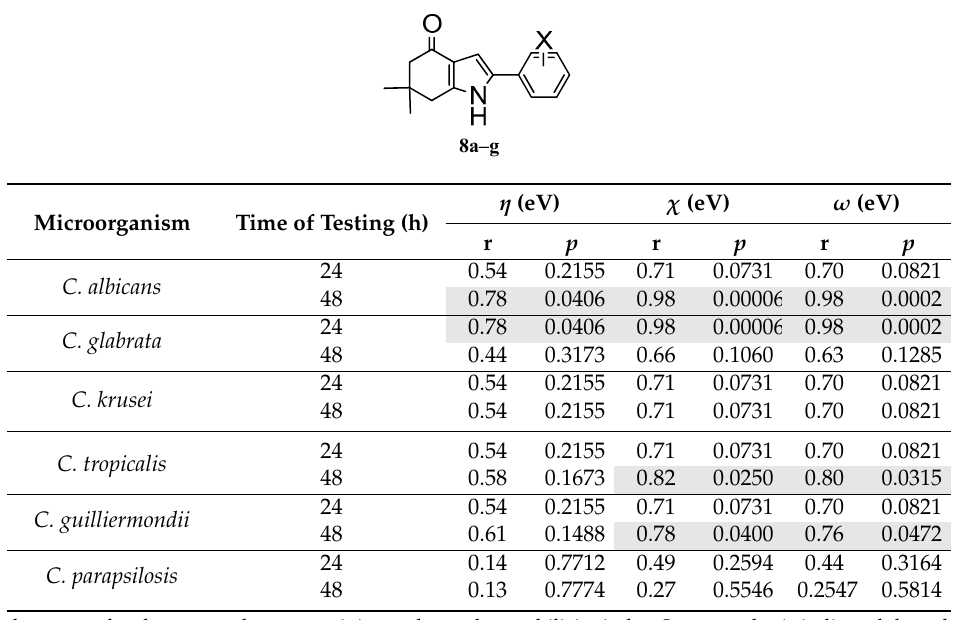
Table 4. Pearson coefficient for simple lineal regression for series II: Compounds 8a – g .